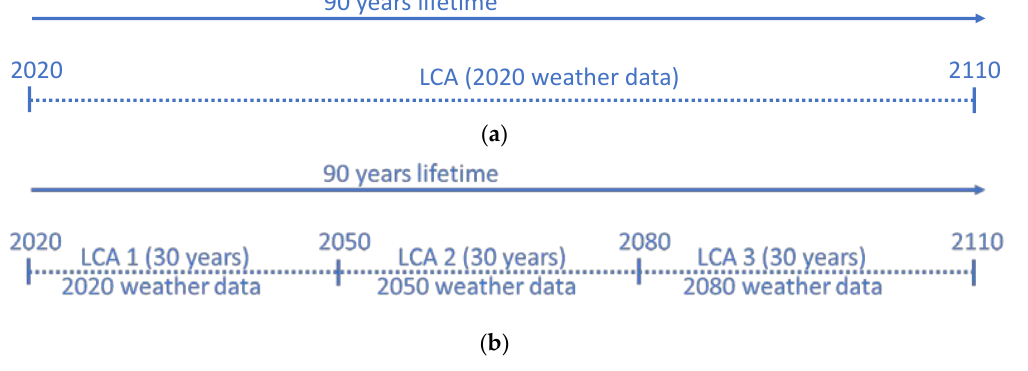
Figure 2. Life cycle assessment: ( a ) Considered as a benchmark (LCA b ); and ( b ) proposed in this study (LCA cc ).